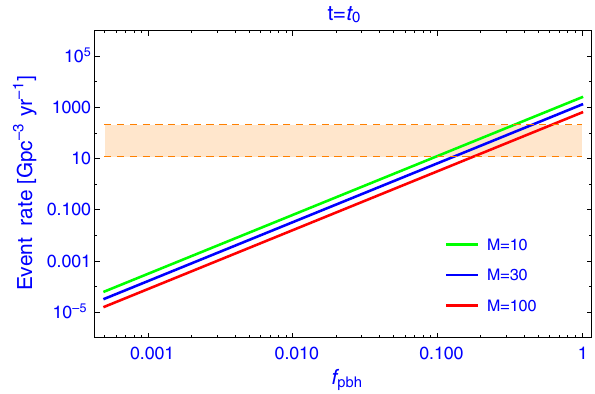
Fig. 4 Event rate of second-merger of PBH binaries with the mass M = 10 (green), 30 (blue) and 100 (red) in M (cid:2) at the present time as a function of the PBH abundance. The merger rate R = 12– 213 Gpc − 3 year − 1 , inferred by the LIGO and Virgo Collaboration, is shown as the shaded region colored orange [29]